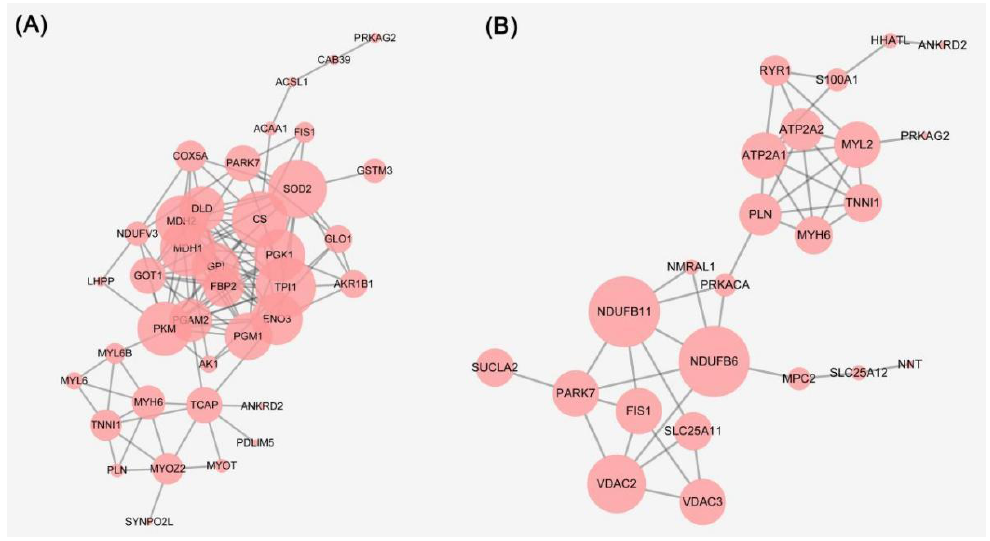
Figure 3. ( A ) Protein-protein interaction networks of differentially expressed proteins of 6 h vs. 0 h PM. ( B ) Protein-protein interaction networks of differentially expressed proteins of 24 h vs. 6 h PM.